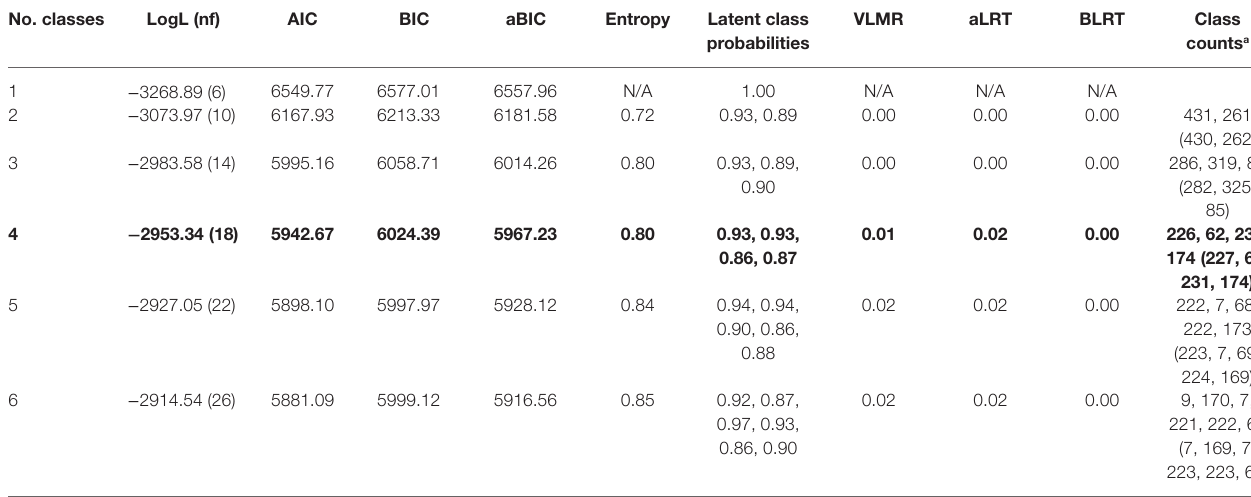
TABLE 2 | Information criteria values for different profile solutions in